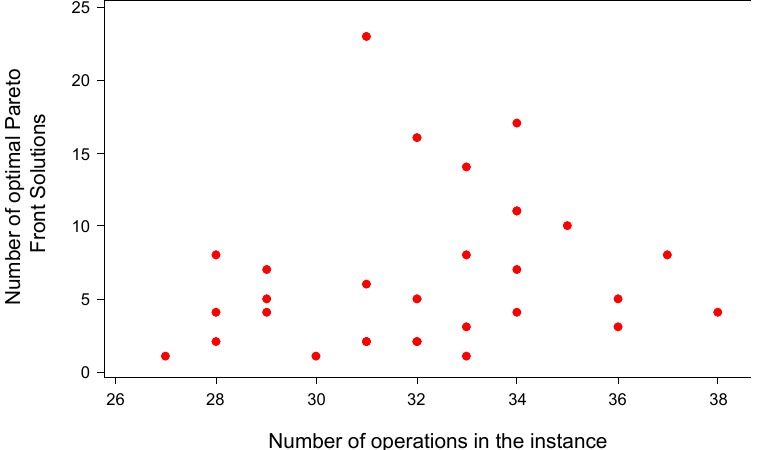
Figure 4. A histogram showing the frequency distribution of the number of optimal Pareto front solutions.